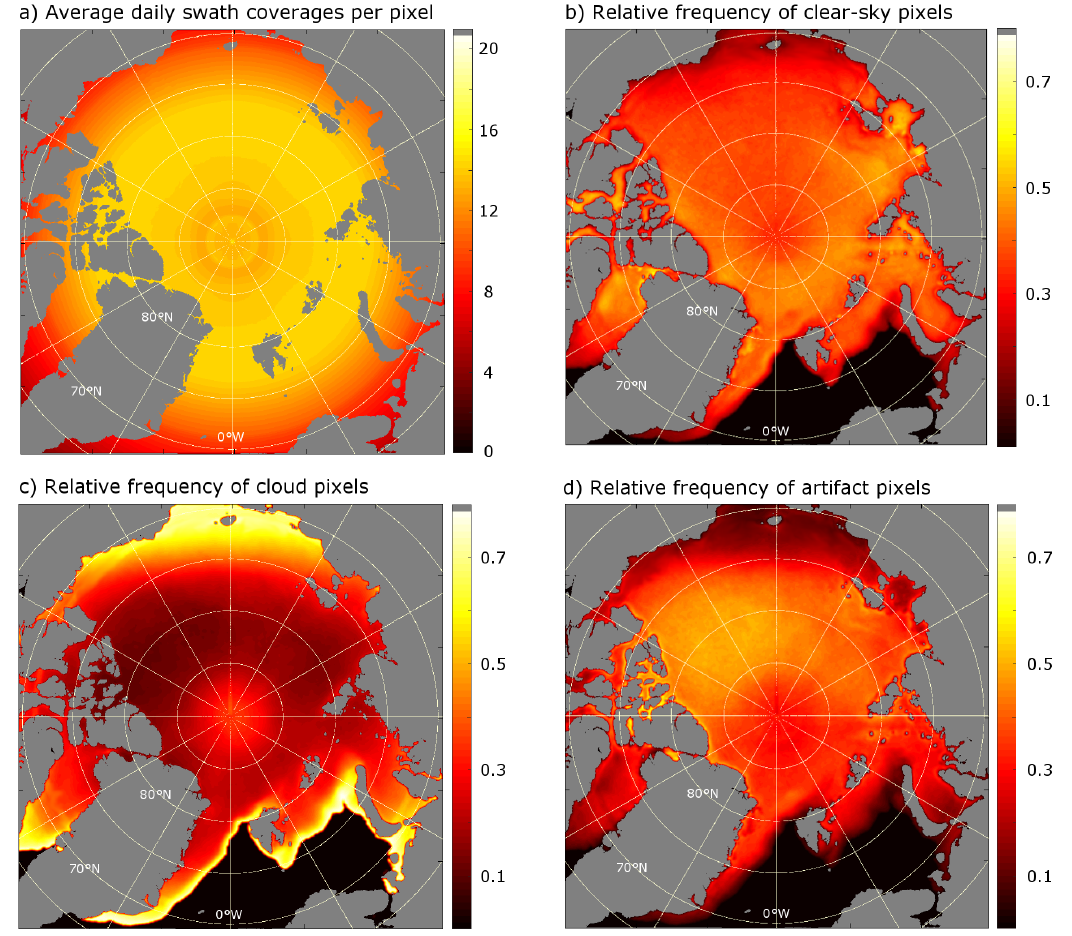
Figure 3. ( a ) average number of swath coverages per day; ( b ) relative frequency of clear-sky pixels (lead or sea ice detections); ( c ) relative frequency of cloud pixels remaining in the daily aggregate and ( d ) relative frequency of artifact detections; ( b ) to ( d ) relative to the total number of days, January to April, 2003–2015 ( n = 1560 days). Values in ( b –d) add up to